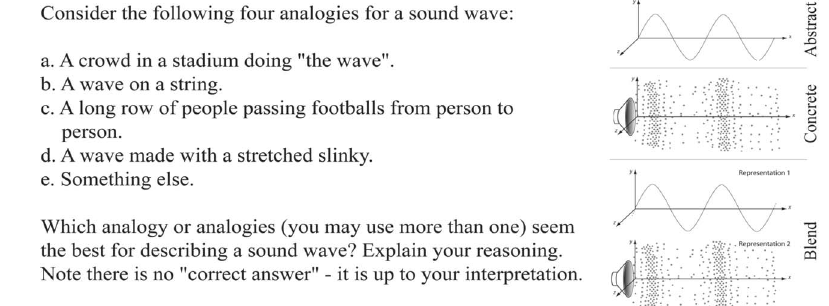
FIG. 8. Question 1 from the sound waves quiz. Each group (cid:1) abstract, concrete, and blend (cid:2) received a different representation shown on the right.